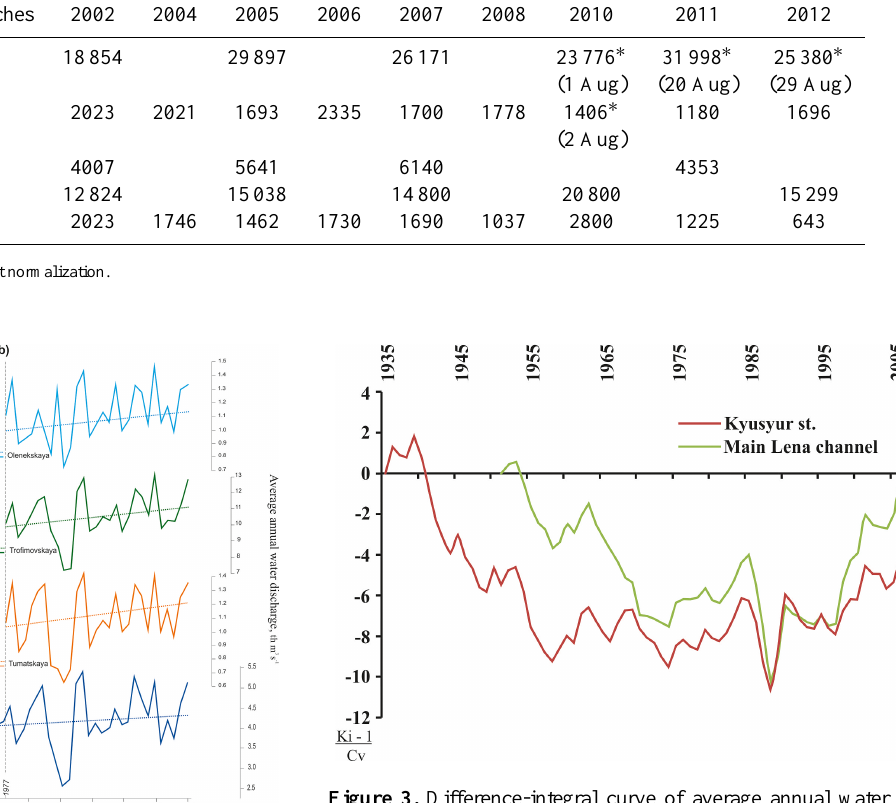
Figure 3. Difference-integral curve of average annual water dis- charge from 1935 to 2007 in the Lena River at Kyusyur, and from 1951 to 2005 in the Lena River main channel, at a cross-section 4.7 km upriver from Khabarova. “0” is the rate of water discharge.